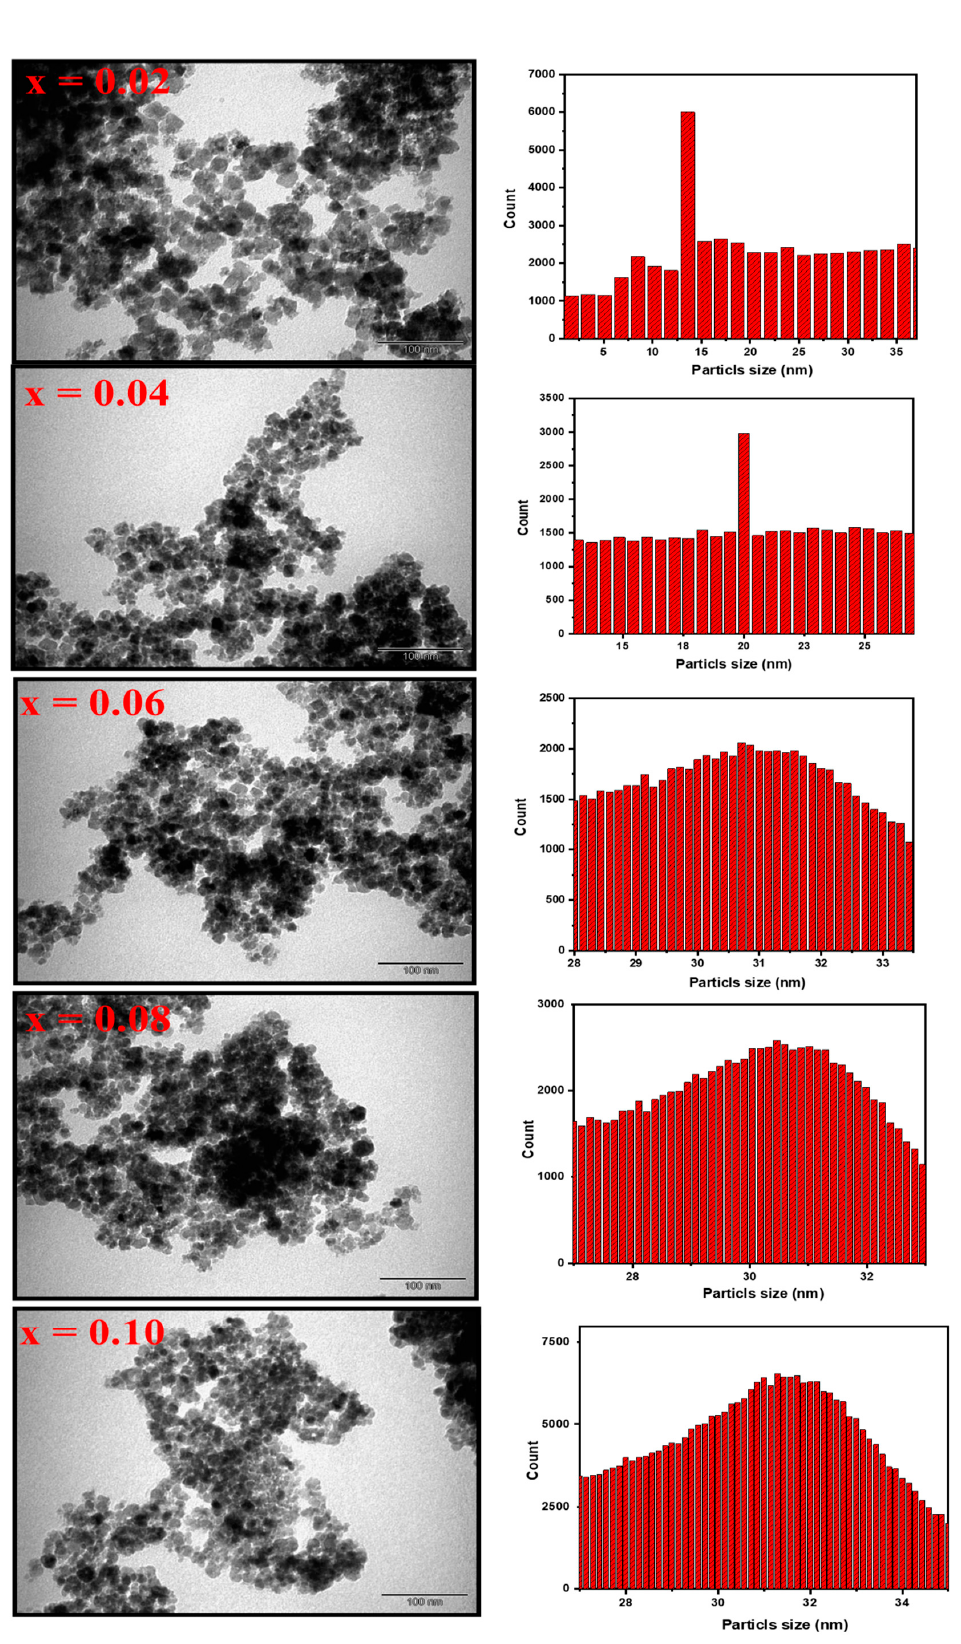
Figure 4. TEM images of Mn 0.5 Zn 0.5 Er x Y x Fe 2 − 2x O 4 NPs (x = 0.02, 0.04, 0.06, 0.08, 0.10) and histogram of particle size distribution.